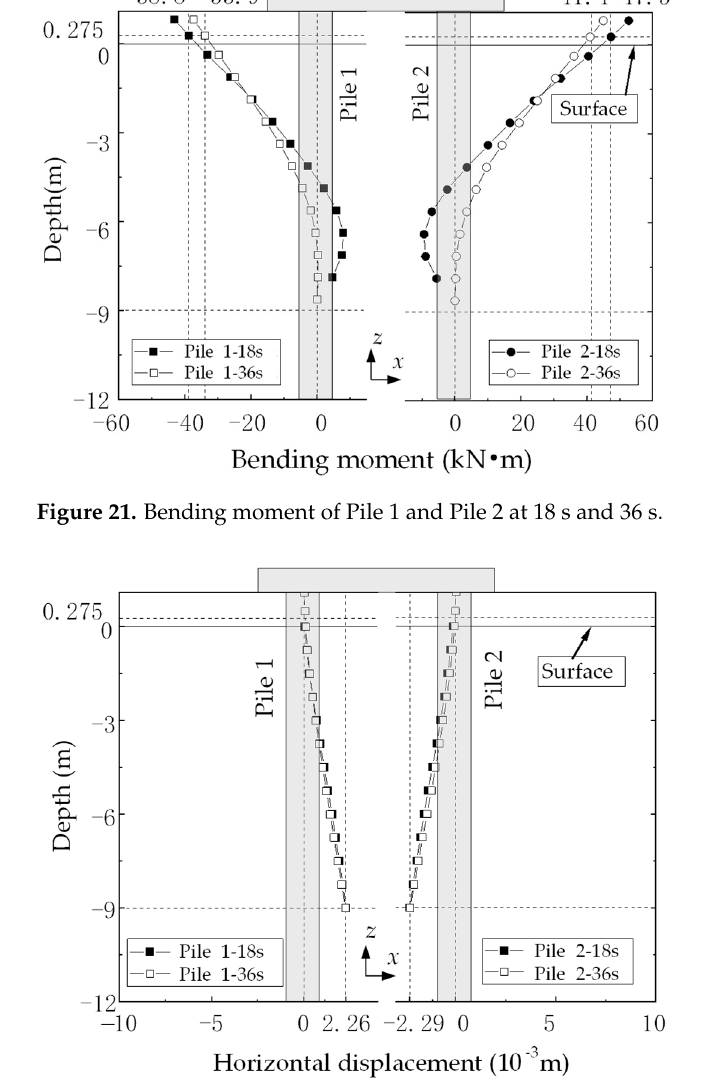
Figure 23. Displacement vector at the end of dynamic loading (deformation being amplified 10 times).